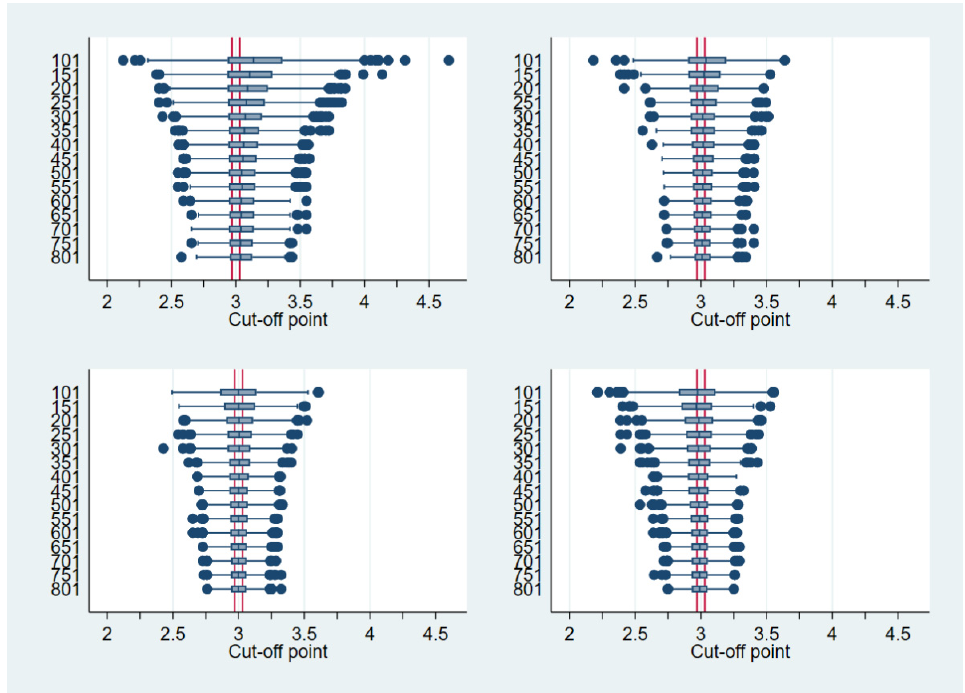
Figure 2. Boxplots of chosen cut-off points by sample size for scenario 1 and a prevalence of 0.1 ( top left ), 0.3 ( top right ), 0.5 ( bottom left ), and 0.7 ( bottom right ). Values smaller than the first quartile minus 1.5 times the interquartile range and values larger than the third quartile plus 1.5 times the interquartile range are shown individually as outliers. The vertical, solid lines indicate a maximum of 1% deviation from the true optimal cut-off point (target area).